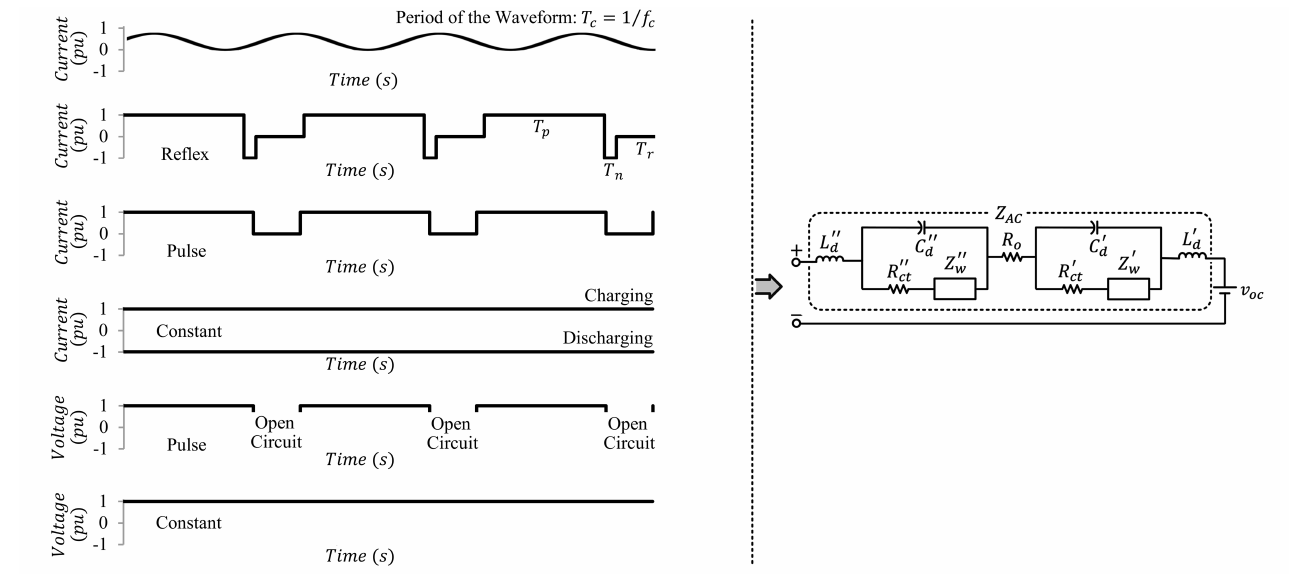
Figure 10. Various voltage and current waveforms for charging and